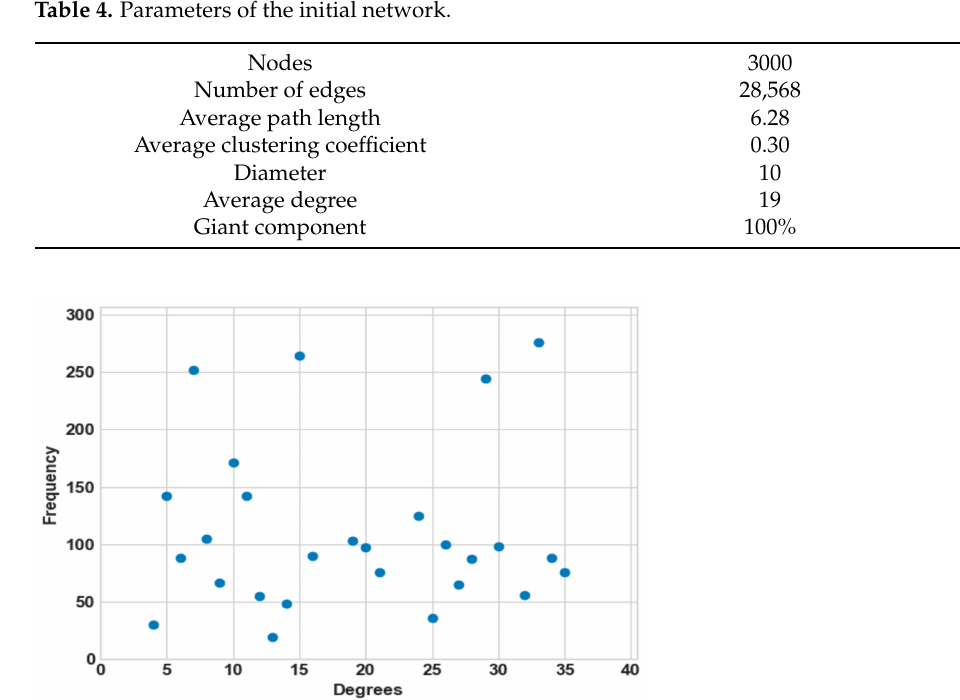
Table 4. Parameters of the initial network.